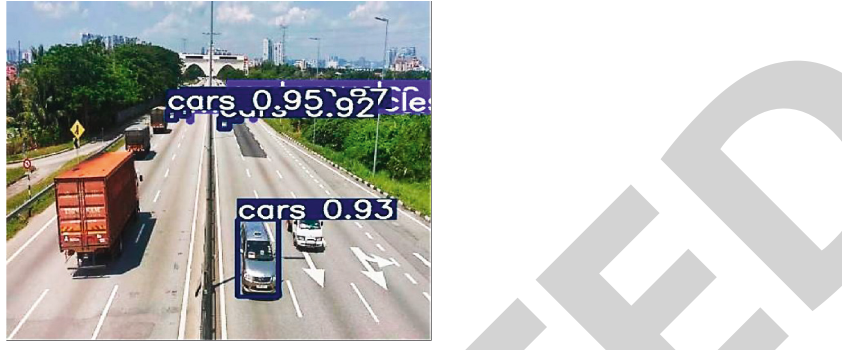
Figure 12: Model accurately detecting the predefined classes in daytime dataset (A).